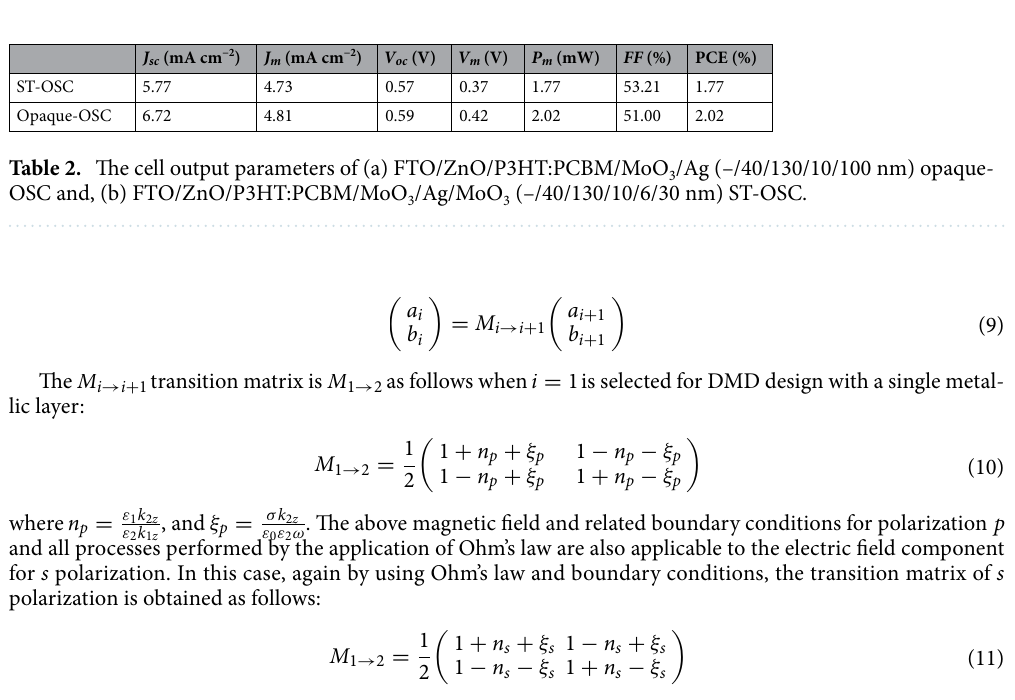
V characteristics of ( a ) FTO/ZnO/P3HT:PCBM/MoO Figure 12. J − and ( b ) FTO/ZnO/P3HT:PCBM/MoO 3 /Ag/MoO 3 (–/40/130/10/6/30 nm) ST-OSC.